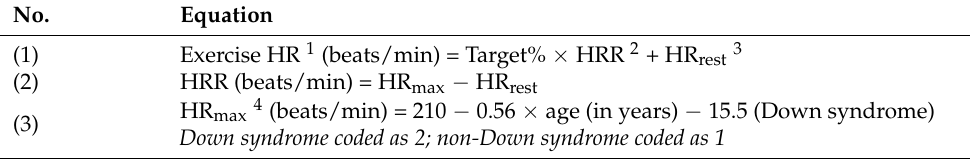
Table 1. Equations for calculating target exercise heart rate [21].